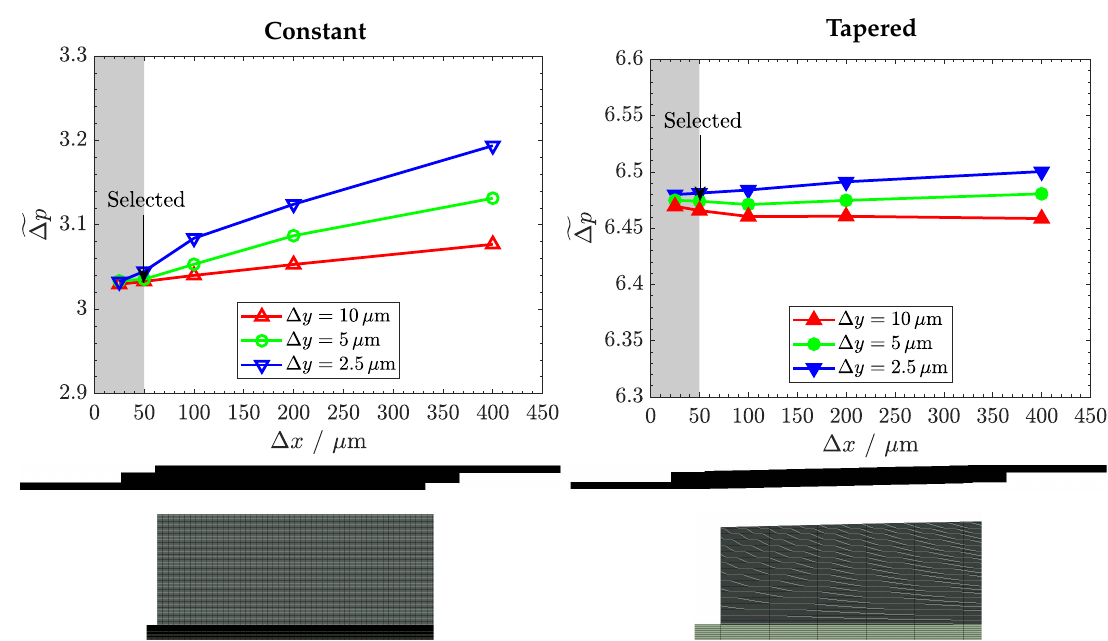
Figure A1. Variation of the overall pressure drop, (cid:102) ∆ p , as a function of the spacing in the x and y directions, ∆ x and ∆ y , of the structured meshes used in the simulations of the constant cross-section and tapered flow fields. The selected meshes ( ∆ x = 50 µ m and ∆ y = 5 µ m) are shown at the bottom, together with a close-up view of the dead-ended region. Electrode permeability, K e = 10 − 10 m 2 ( γ ∼ 1 ) , Λ = 26.67 and Re = 800.